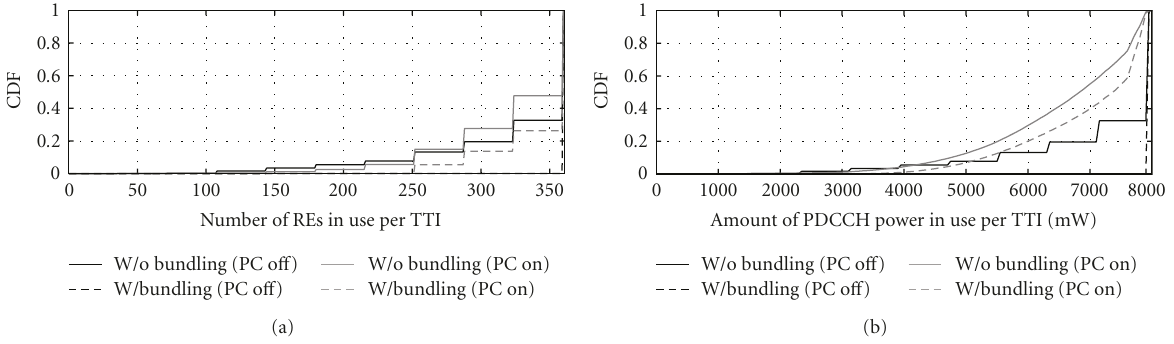
Figure 9: CDF of utilization rate of PDCCH CCE and power per TTI (Macro Case 3).